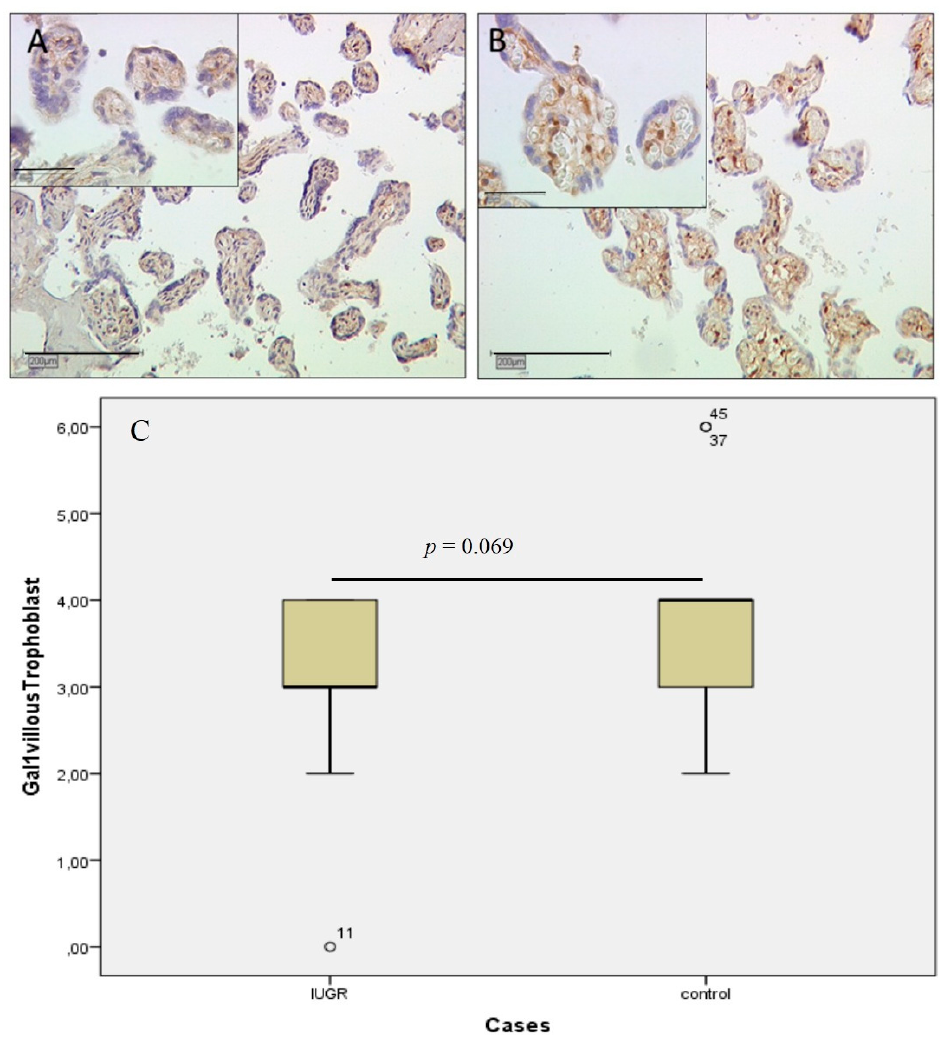
Figure 1. Staining of gal-1 in the villous trophoblast in cases of IUGR is shown in ( A ); for comparison with control placenta, see ( B ), showing only slight differences in staining intensity. The presentation of staining results is shown in ( C ) as a box-plot. The range between the 25th and 75th percentiles is represented by the boxes with a horizontal line at the median. The bars show the fifth and 95th percentiles. The circle indicates values more than 1.5 box lengths.